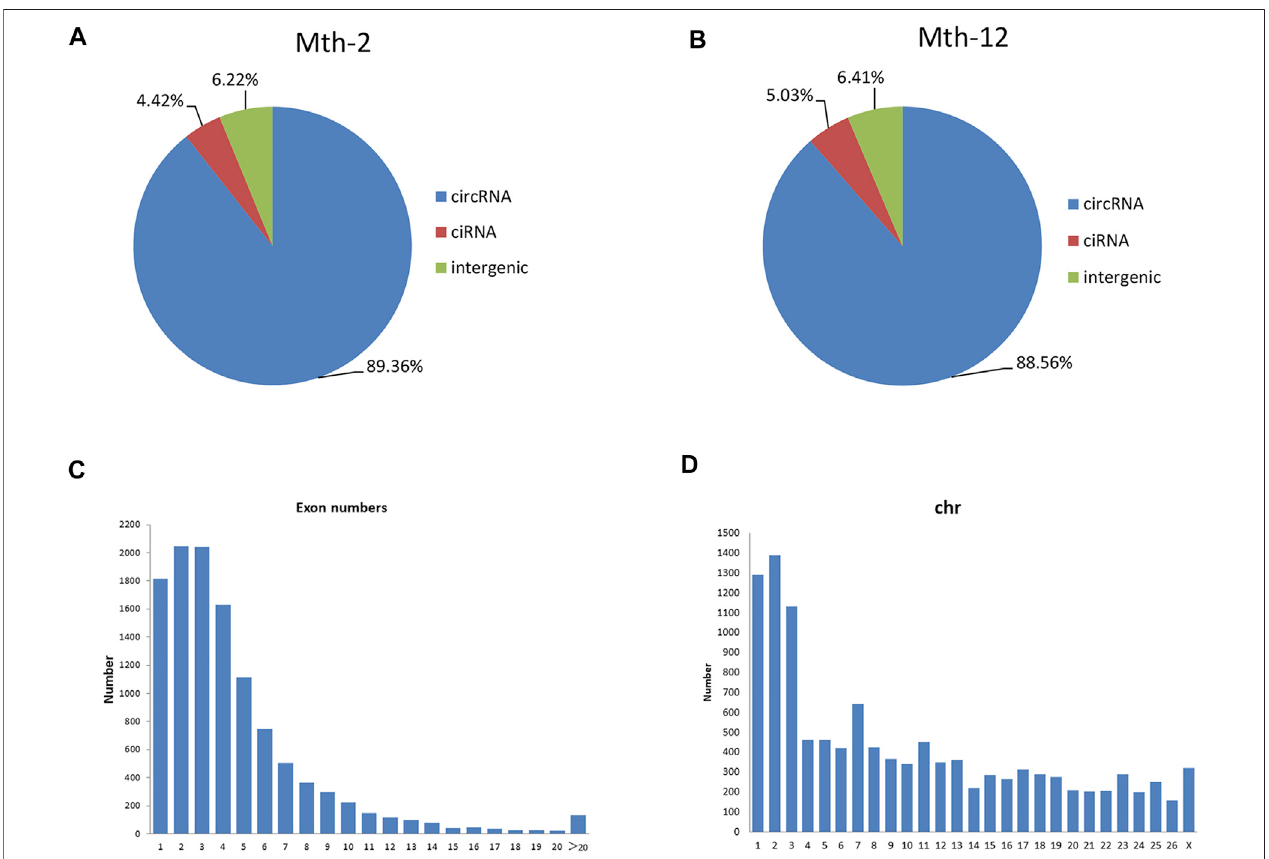
FIGURE 1 | General characteristics of Aohan fi ne-wool sheep (AFWS) circular RNAs (circRNAs); (A) The types of circRNAs in 2-month-old (Mth-2) rams; (B) The types of circRNAs in 12-month-old (Mth-12) rams; (C) The number of exons; (D) Distribution of circRNAs on the chromosomes.